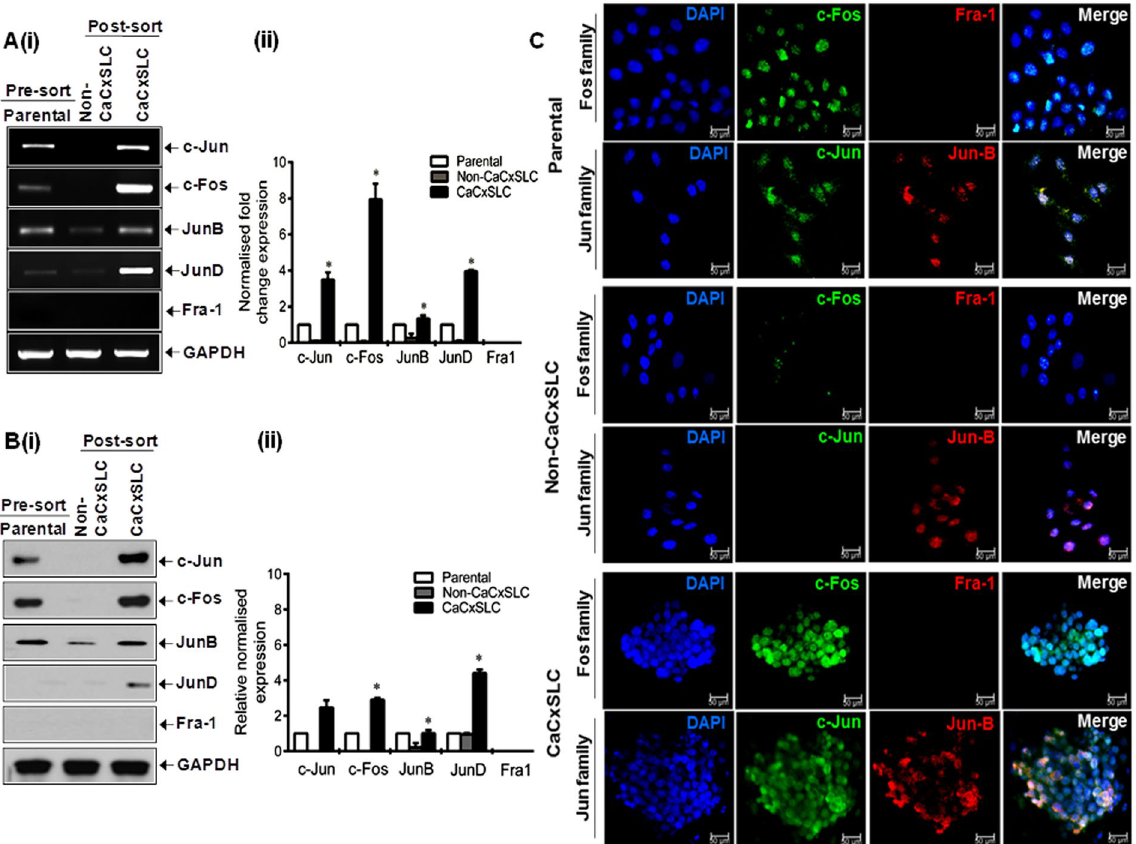
Figure 3. Expression of AP-1 members in CaCxSLCs. ( A ) Transcript levels of AP-1 family members. Representative cropped gel photographs showing relative transcript levels of indicated AP-1 members in cDNA prepared from CaCxSLCs and non-CaCxSLCs by qRT-PCR. cDNA from parental SiHa cells were used as reference. GAPDH qRT-PCR was used as input control for normalization as described in Methods (i). The gels were run under the same experimental conditions. Normalized fold change in transcript levels is expressed as mean ± SD of three independent experiments (ii). * p-value < 0.05 vs. parental SiHa cells. ( B ) Representative cropped blots showing expression levels of c-Jun, c-Fos, JunB, JunD and Fra-1 in total cellular extracts derived from CaCxSLCs culture and non-CaCxSLCs or presorted SiHa cultures. β -actin was used as input control (i). The abundance ratio of each AP-1 members to β -actin was analyzed by densitometry. The gels were run under the same experimental conditions. The relative normalized fold change in the protein is expressed as the mean ± SD of three independent experiments (ii). * p -value < 0.05 vs. parental SiHa cells. ( C ) Intracellular expression of cellular AP-1 protein in CaCxSLCs. Representative confocal immunofluuorescence image of AP-1 family members in day10 cultured cervicosphere CaCxSLCs and non-CaCxSLCs cultures. Parental SiHa cells were used as